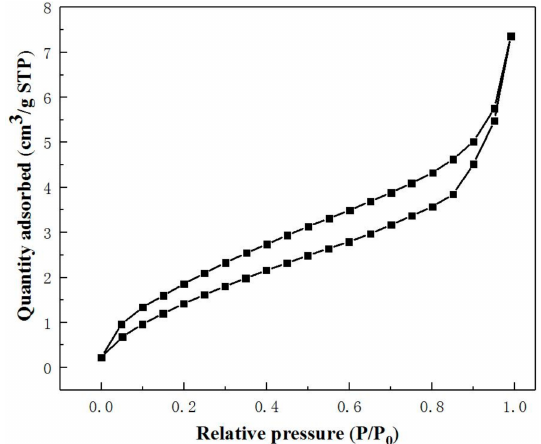
Figure 6. The N 2 adsorption / desorption isotherms of